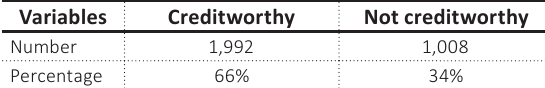
Table 2. Portfolio allocation